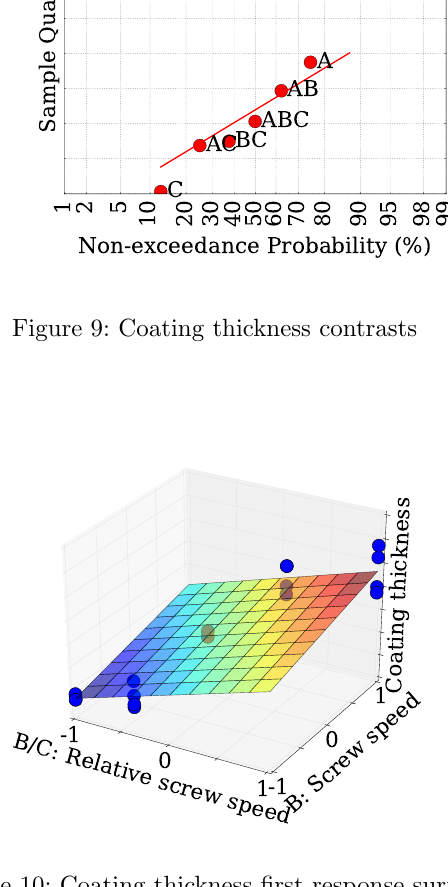
Figure 10: Coating thickness first response surface